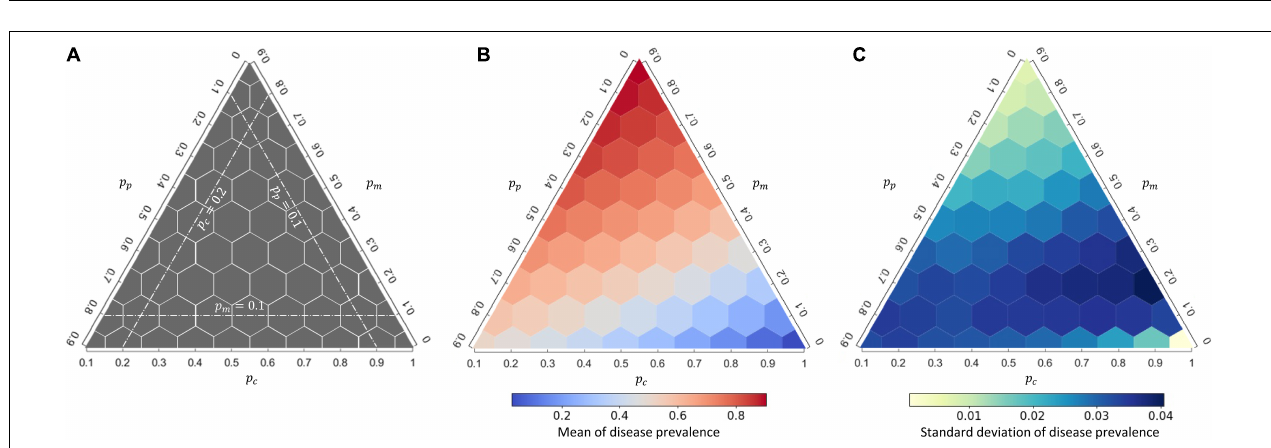
FIGURE 1 | A conceptual diagram of the modeling procedure. (A) Population dynamics of a randomly assembled host network. (B) Interaction compositions of the initial (blue) and final (red) networks when population dynamics have reached equilibrium. (C) Summary diagrams of the effects of interaction composition and transmission mode on community metrics, disease prevalence and the diversity-disease relationship.